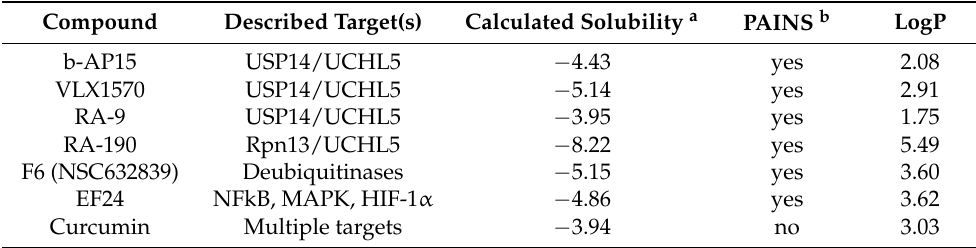
a Calculated solubility, LogS (ESOL). b Pan-assay interference compounds.